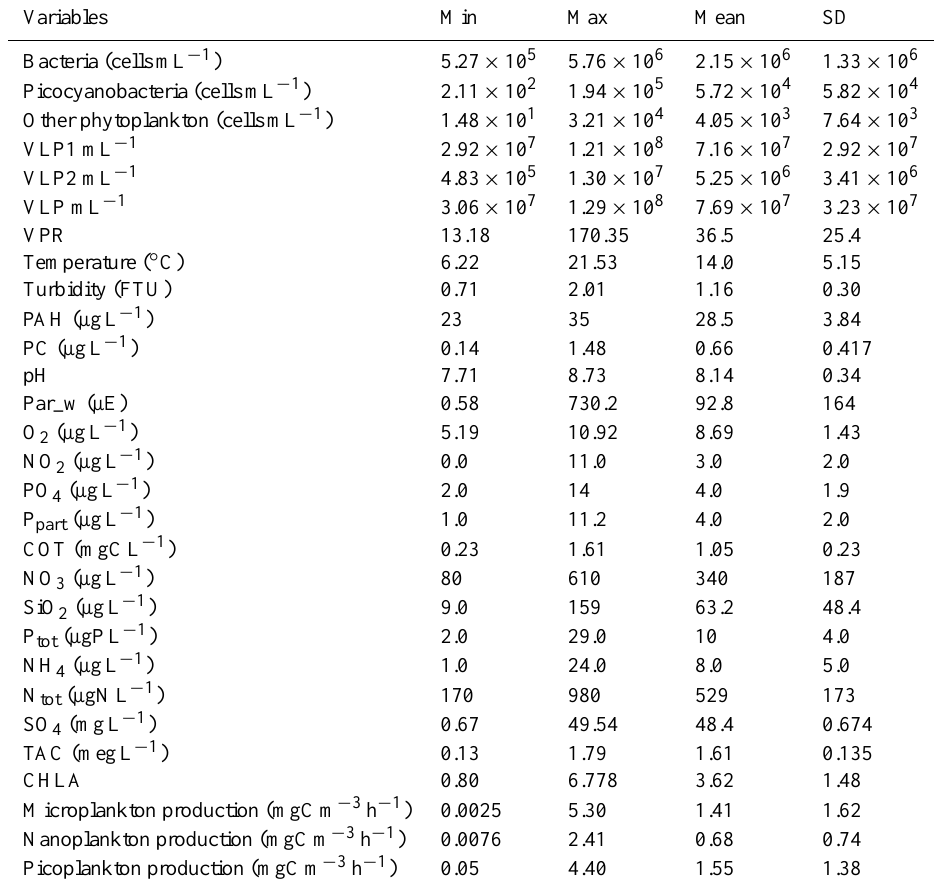
Table 1. Minimum, maximum, mean and standard deviation values for all the variables measured in Lake Geneva in this study from July to November 2011. Abbreviations are mentioned in the